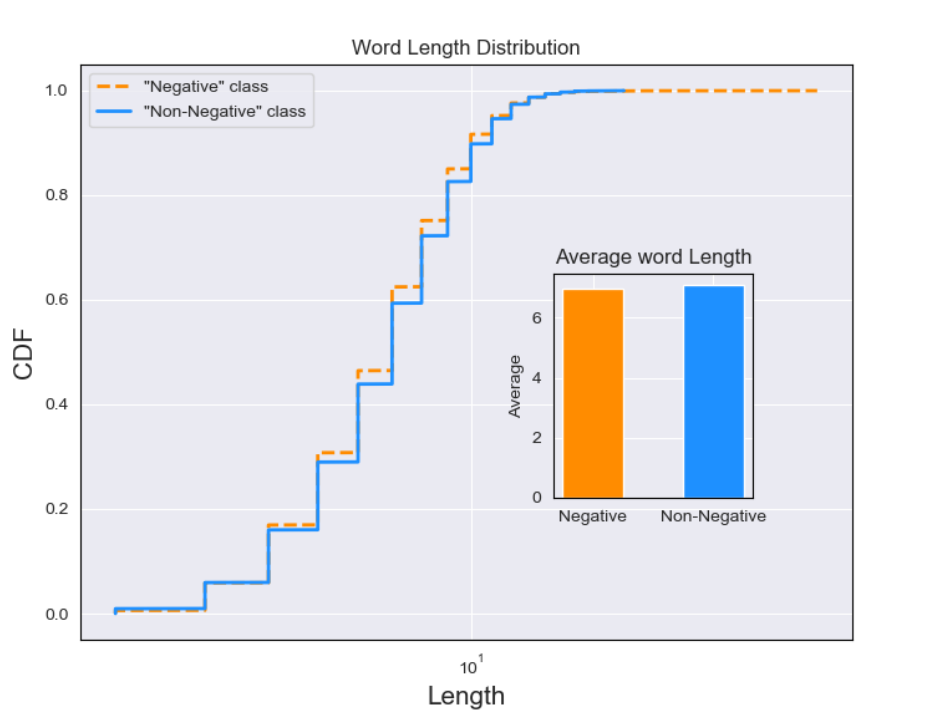
Figure 5. Cumulative Distribution Function of word lengths and averages (inner plot) for both classes.